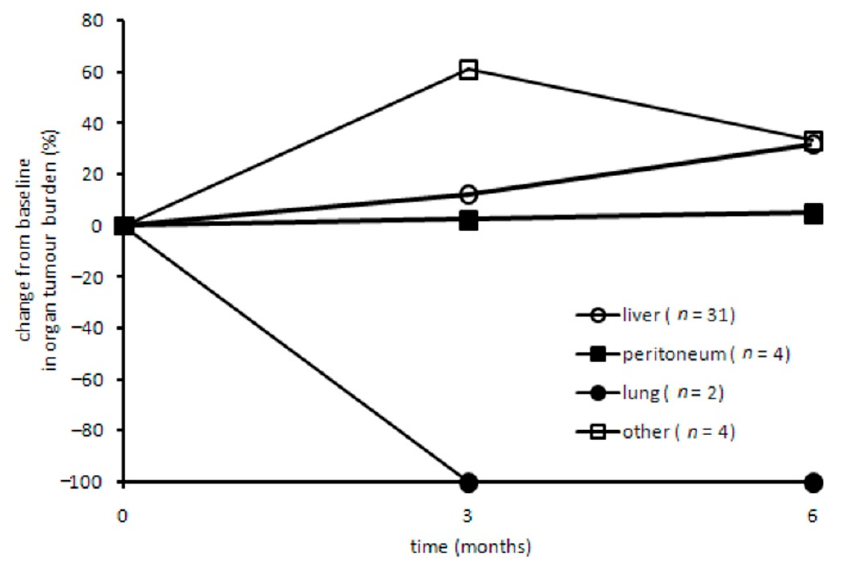
Figure 2. Best percentage change in single lesions. Best percentage change from baseline depicted for every single lesion analyzed. Circles indicate liver lesions with null change.